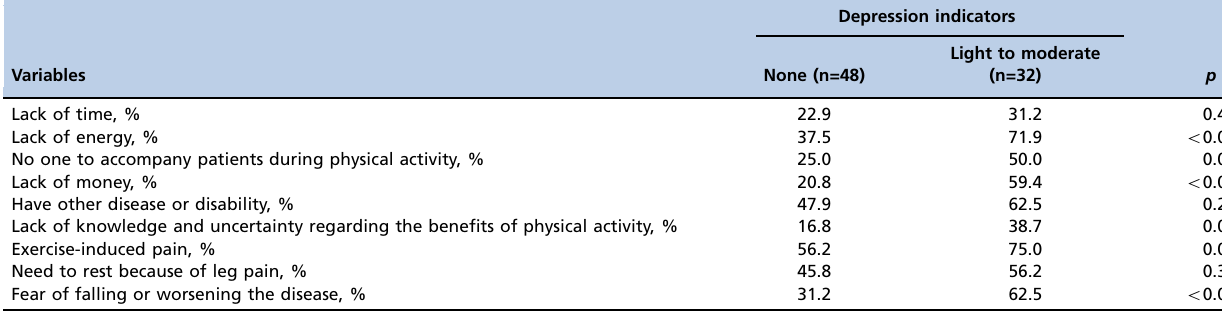
Table 3 - Association between barriers to physical activity and depressive symptoms (n=80).